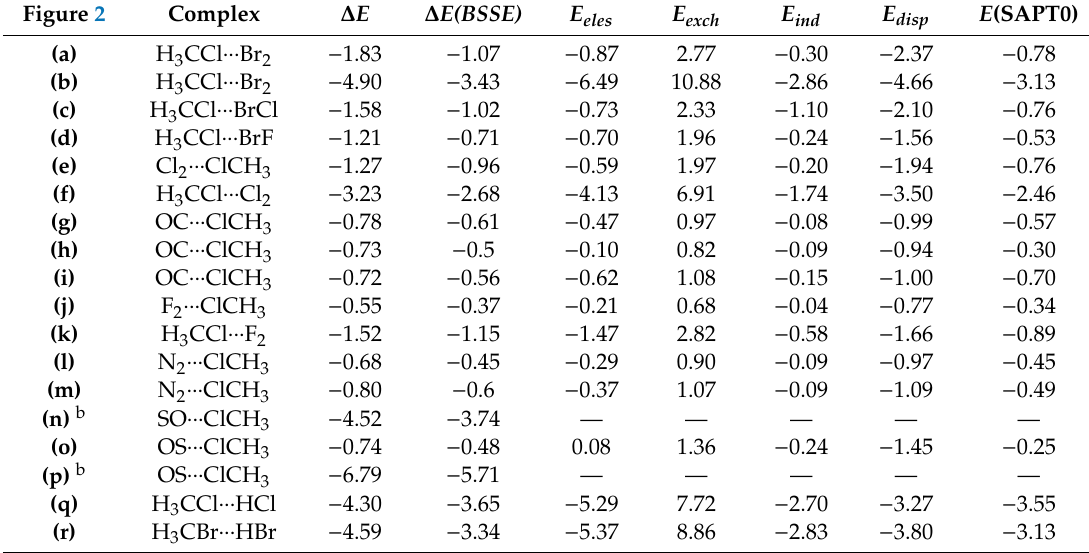
Table 2. Comparison of the MP2 / aug-cc-pVTZ computed binding energies with the density functional theory symmetry adapted perturbation theory (DFT-SAPT) interaction energies for the 18 binary complexes of CH 3 Cl a